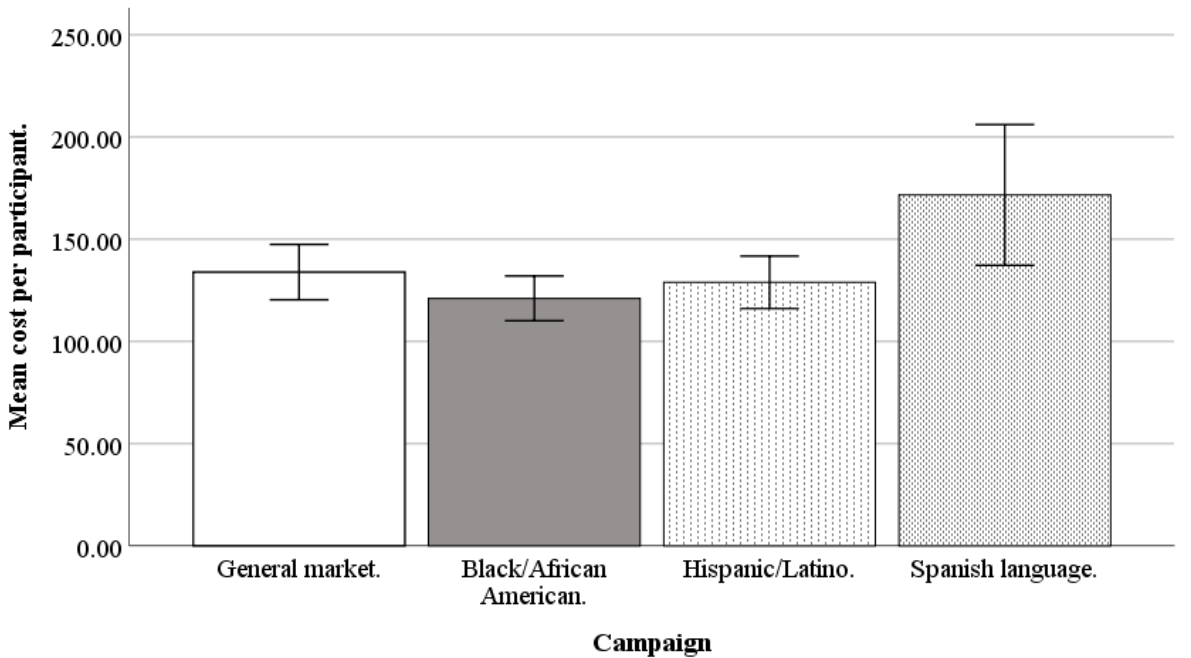
Figure 13. Mean costs per participant for Facebook advertising